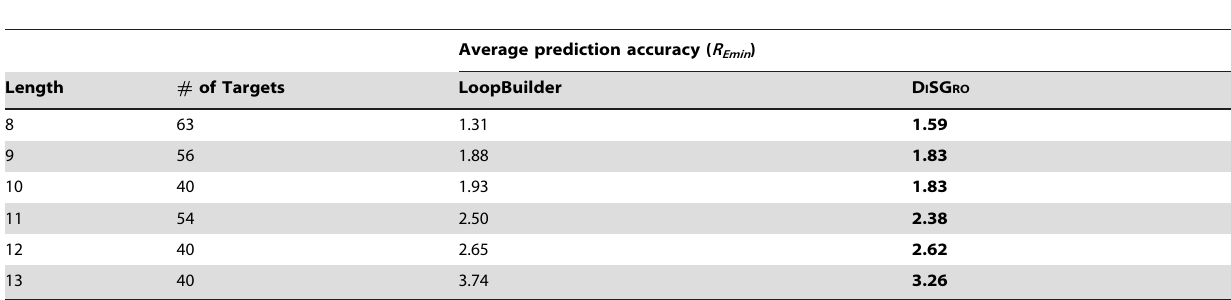
Table 5. Comparison of R Emin of the loop conformations sampled by Loop Builder and D I SG RO using Test Set 4 taken from the Loop Builder study